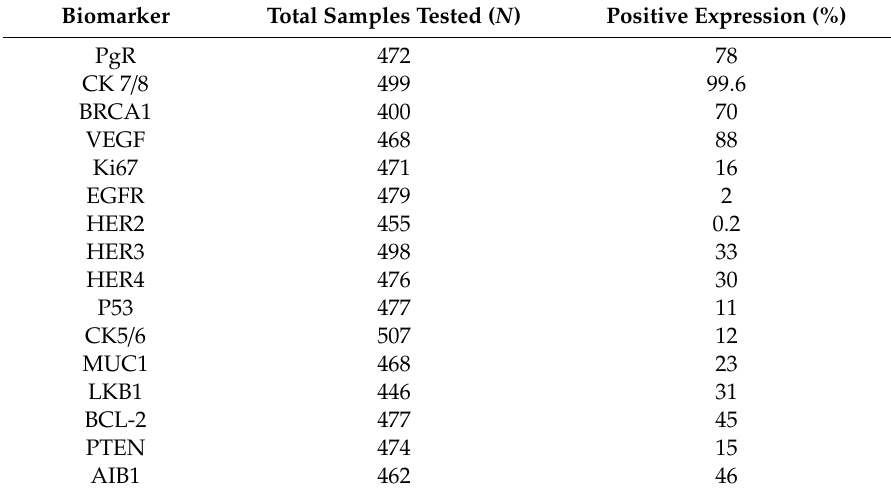
Table 2. Percentage expression of biomarkers in the whole population of ER-positive early operable breast cancers in the cohort. Biomarkers measured were: progesterone receptor (PgR), Ki67, Epidermal Growth Factor Receptor (EGFR), Human Epidermal Growth Factor Receptor (HER)-2, HER3, HER4, p53, cytokeratins CK5 / 6 and CK7 / 8, Mucin (MUC)1, liver kinase B1 (LKB1), Breast Cancer Associated gene (BRCA)-1, B-Cell Lymphoma (BCL)-2, phosphate and tensin homolog (PTEN), vascular endothelial growth factor (VEGF), and Amplified in breast cancer 1